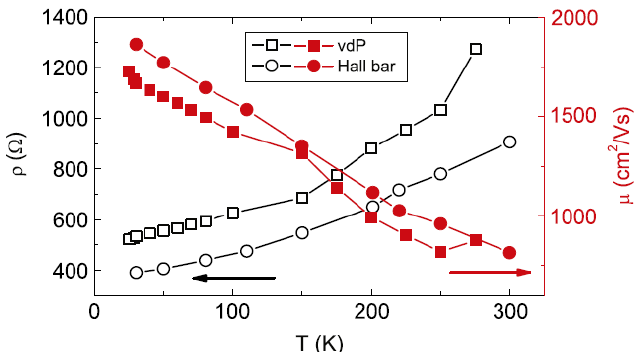
Figure 6. Resistivity, ρ , and mobility, µ , as a function of temperature, T for MLG on SiC, indicating that the measured properties are almost similar for vdP (squares) and Hall bar (circles) structures. Reprinted with permission from Reference [55]. Copyright (2011) Elsevier Ltd.